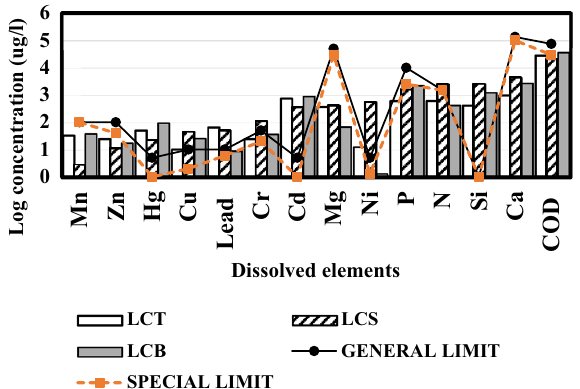
Figure 15. ICP-OES analysis results of LCT: HTC liquid phase from Coal tailing; LCS: HTC liquid phase from coal slurry and LCB: HTC liquid phase from the blending of coal and sewage